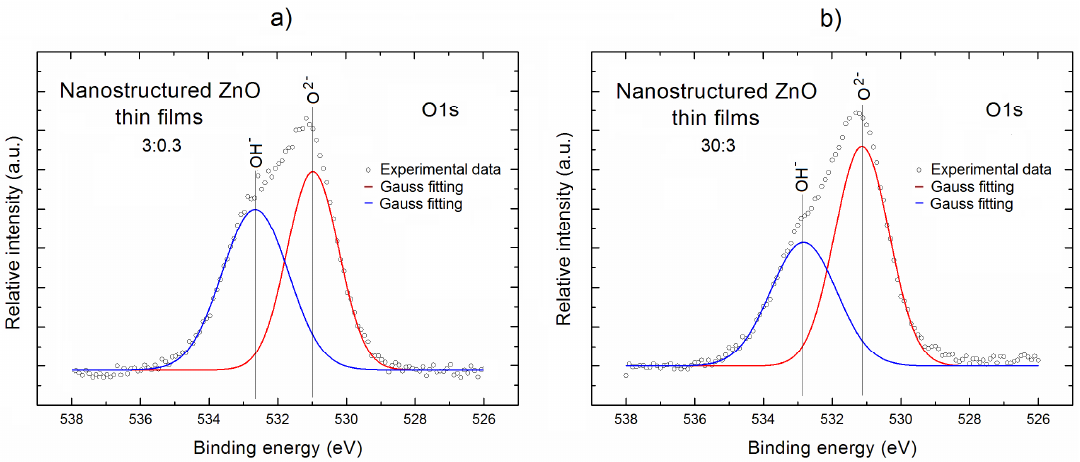
Figure 4. The XPS O1s lines after deconvolution using Gauss fitting for the two selected nanostructured ZnO thin films deposited at Ar/O 2 gas flow of 3:0.3 ( a ) and 30:3 ( b ), respectively, having the most different total relative O concentration.